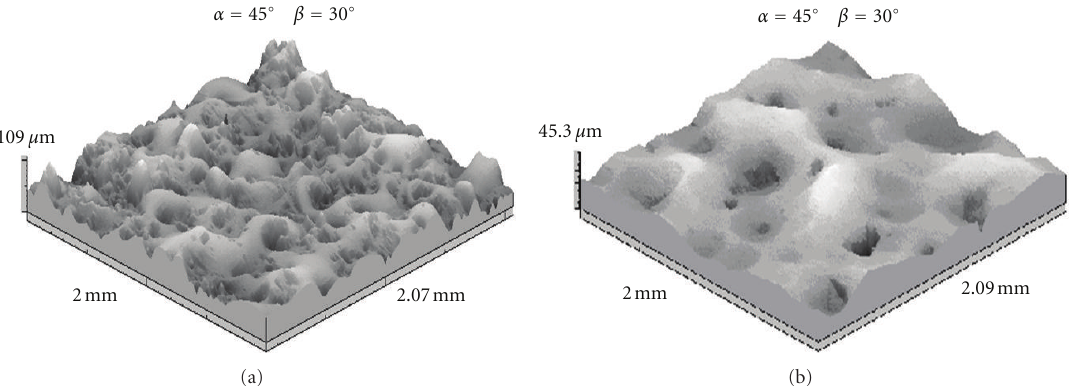
Figure 13: Stereometric image of the surface subjected to the: (a) EDA: 1H18N9 electrode, I = 24(A), Ti = 400 ( μ s), U = 200 (V), (c) EDA + roto peen n = 4100 (obr/min), t = 75(s).